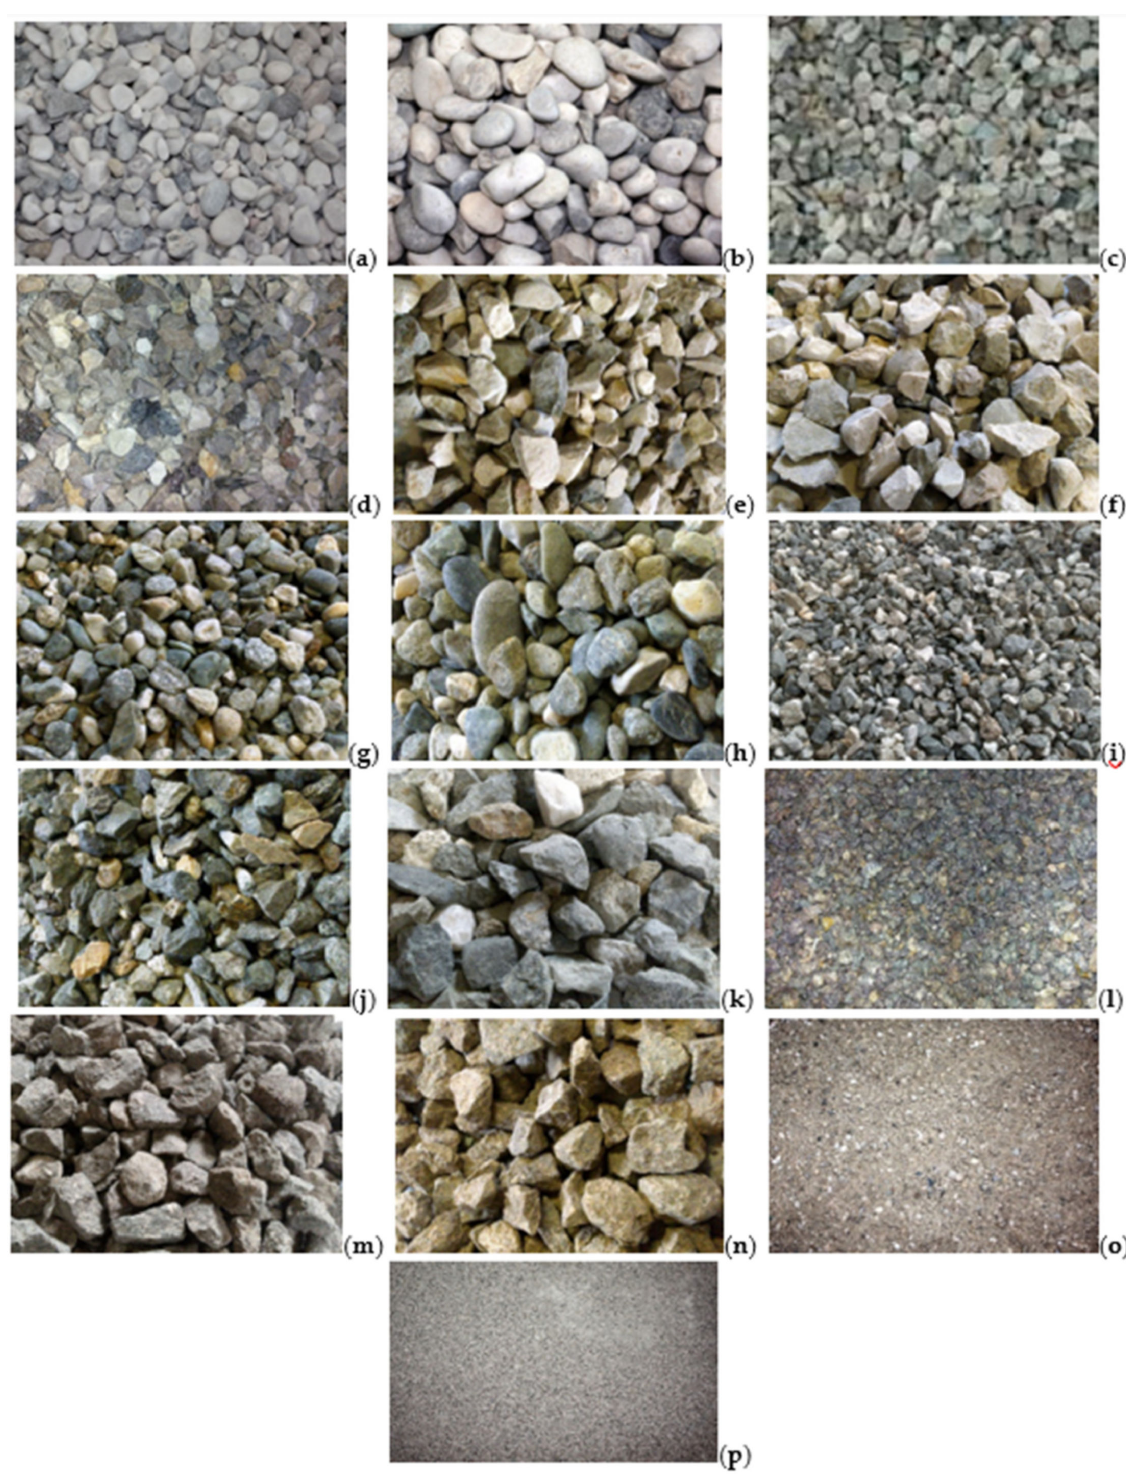
Figure 2. Photo imaging of the samples analyzed: ( a ) calcareous gravel 6/16; ( b ) calcareous gravel 16/32; ( c ) calcareous crushed stone 4/8; ( d ) calcareous crushed stone 8/12; ( e ) calcareous crushed stone 12/20; ( f ) calcareous crushed stone 20/28; ( g ) metamorphic gravel 5/16; ( h ) metamorphic gravel 15/30; ( i ) metamorphic crushed stone 5/9; ( j ) metamorphic crushed stone 9/16; ( k ) metamorphic crushed stone 16/25; ( l ) porphyry 4/8; ( m ) porphyry 8/20; ( n ) porphyry 16/31; ( o ) calcareous sand 0/6; ( p ) calcareous sand